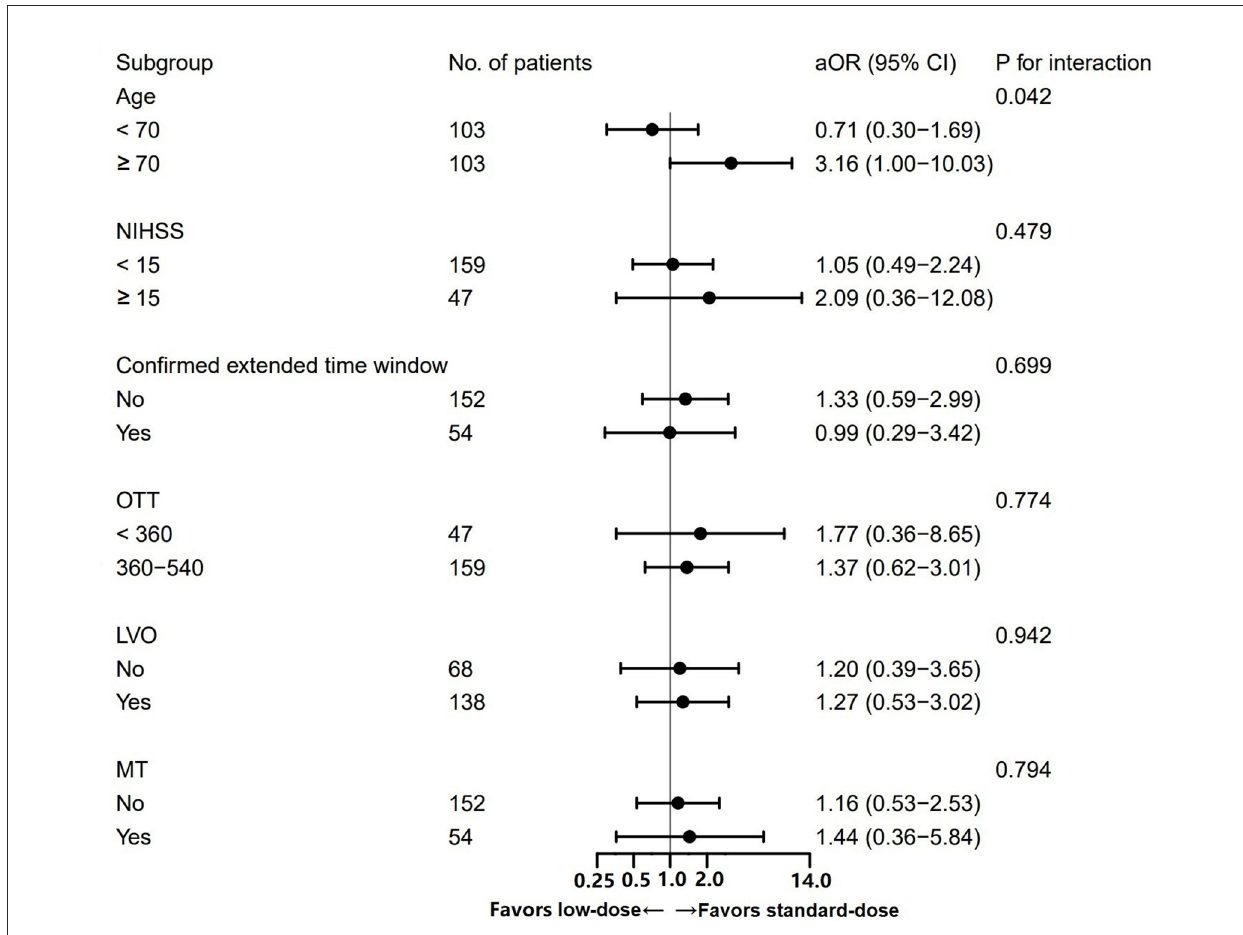
FIGURE3 Subgroup analysis of the excellent functional recovery between patients treated with standard- vs. low-dose